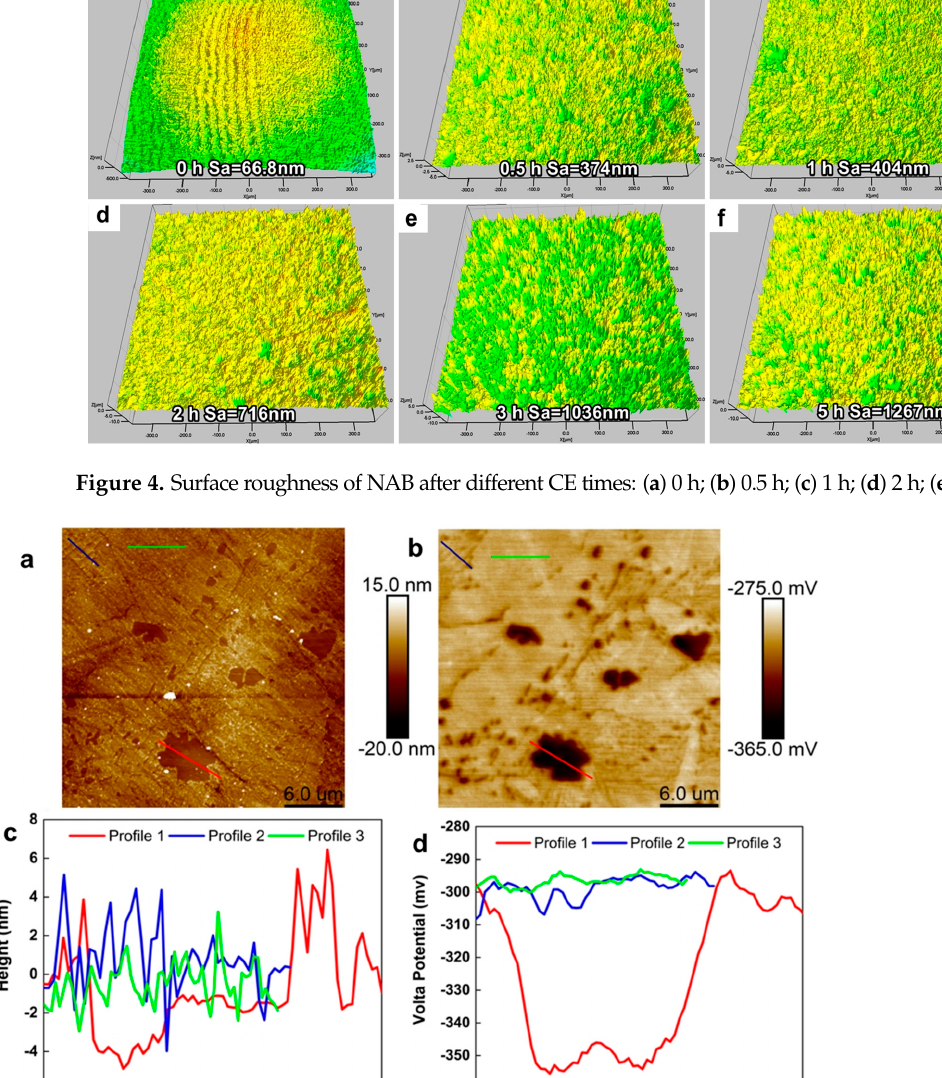
Figure 3. Surface morphologies of NAB after different CE times: ( a ) 0 h; ( b ) 0.5 h; ( c ) 1 h; ( d ) 2 h; ( e ) 3 h; ( f ) 5 h.